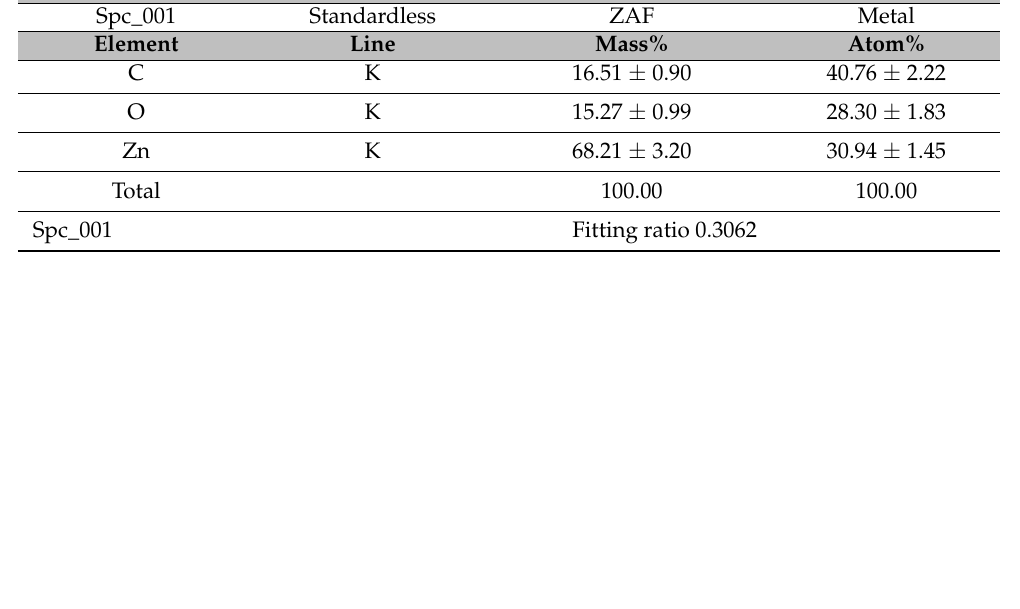
Figure 7. EDS result of ZnONPs of leaf extracts of R. sativus showing measurement conditions.